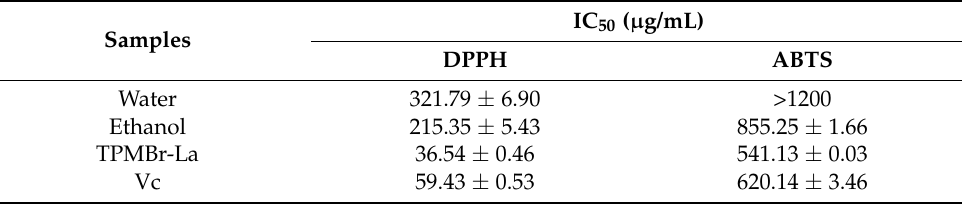
Figure 8. Determination of the DPPH and ABTS radical scavenging capacity of bioactive saponins recovered from water, ethanol, and TPMBr-La. There is a significant difference when * p < 0.05, ** p < 0.01, and *** p < 0.001 versus ethanol. Table 5. The IC 50 value of DPPH and ABTS free-radical scavenging